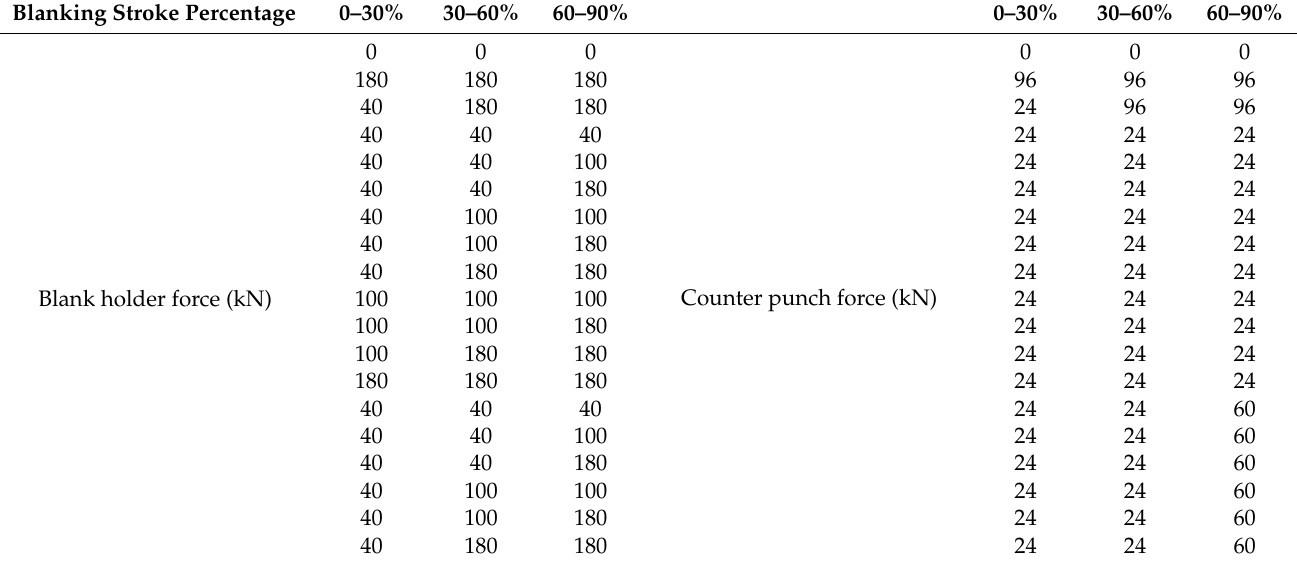
Table 7. Finite element simulation arrangement of blanking under force variation